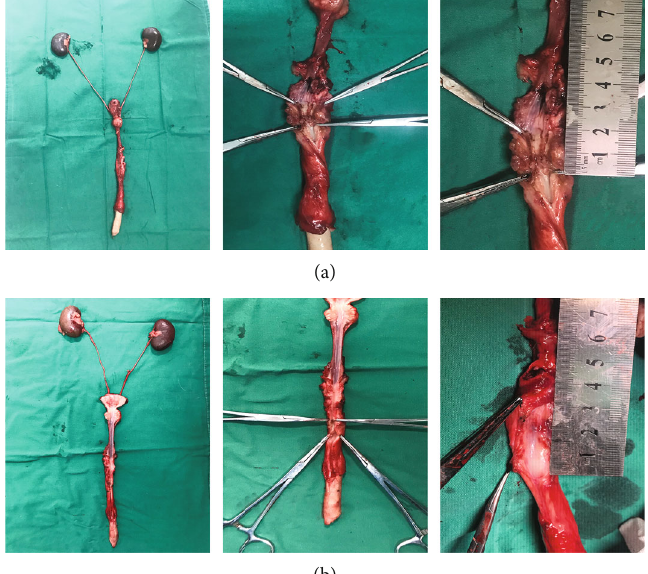
Figure 6: Gross examination of the reconstructed urethra. Graft contracture and scar formation were showed in the control group (a). The graft was highly epithelialized and smooth in the experimental group